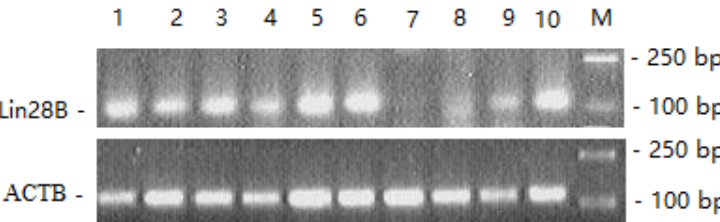
Figure 3. LIN28B gene expression profile in ten tissues. 1, Ovary; 2, spleen; 3, uterus; 4, kidney; 5, hypothalamus; 6, pituitary; 7, lung; 8, heart; 9, liver; 10, oviduct; M, DL2000 Marker. LIN28B, lin-28 homolog B; ACTB,